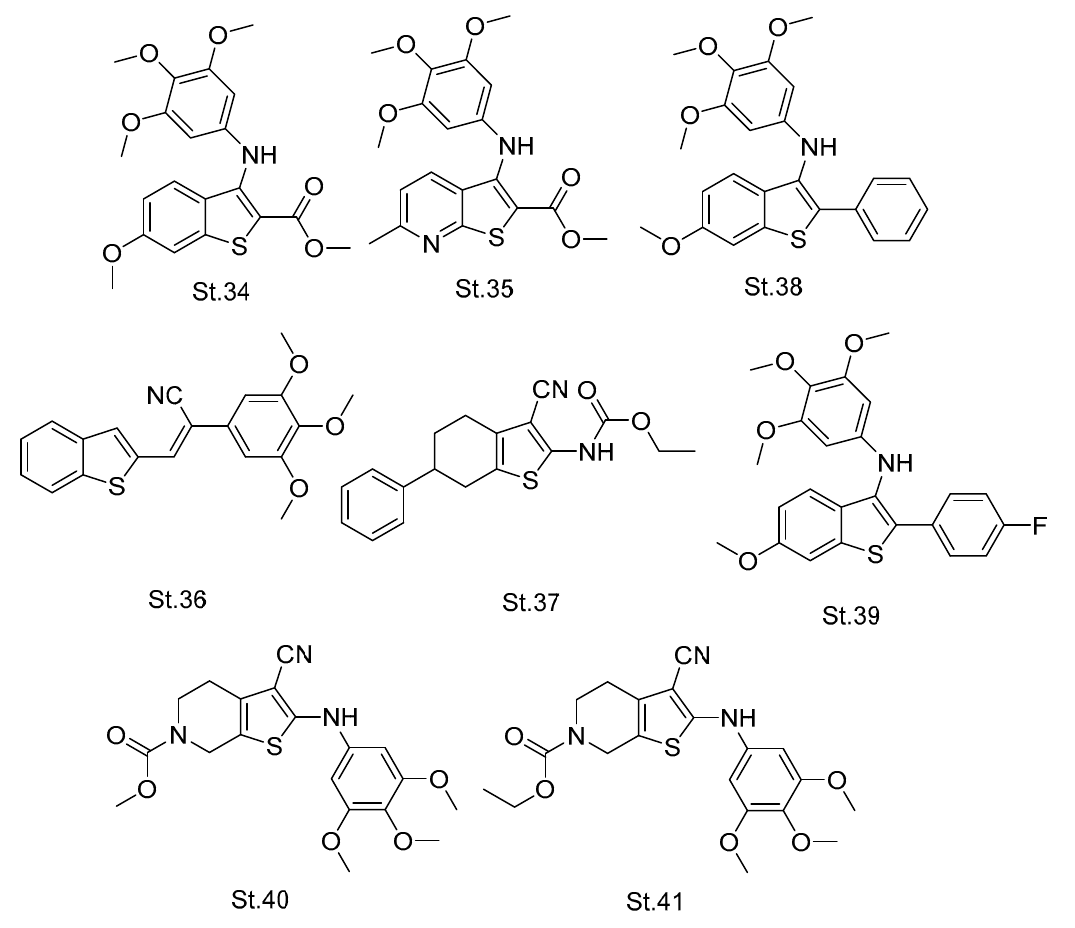
Figure 8. The structures of thiophene analogues.